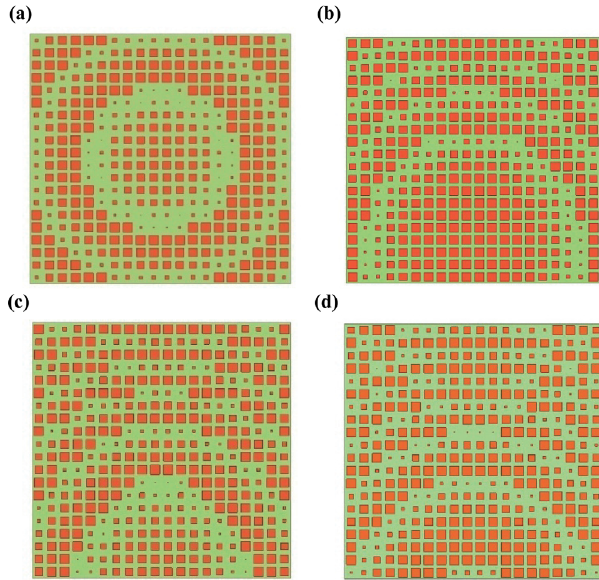
Fig. 8. Designed four high-gain antennas for different main beam directions at (a) u =0 ° , f = 0 ° , (b) u =30 ° , f =0 ° , (c) u =45 ° , f =0 ° , and (d) u =60 ° , f =0 ° .